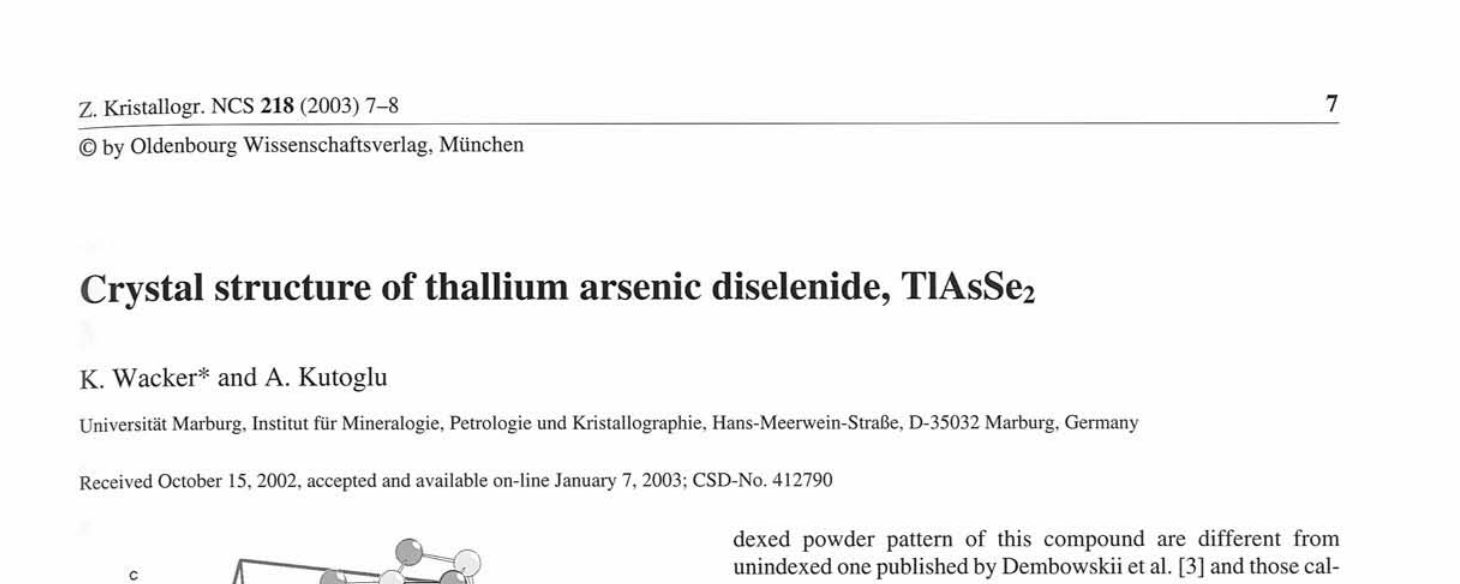
Table 1. Data collection and handling.